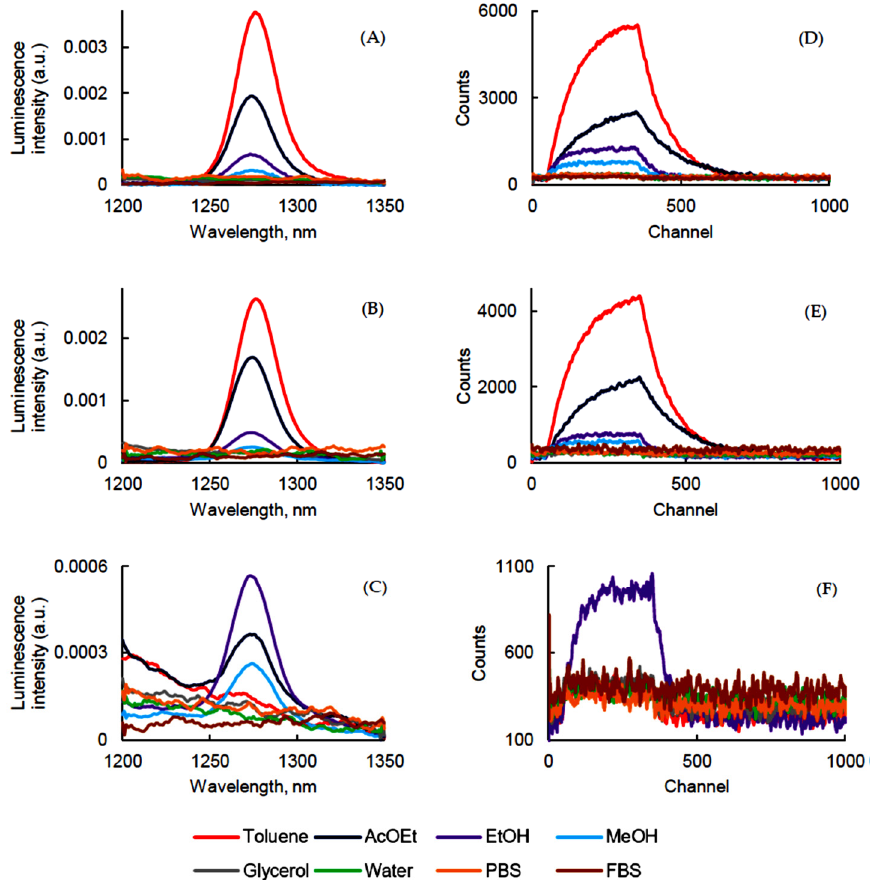
Figure 4. 1 O 2 luminescence emission and decay ( λ exc = 400 nm for PpIX and PF and 415 nm for PPa) of PpIX ( A , D ), PPa ( B , E ), and PF ( C , F ) in different solvents (c = 1.87 μ M).